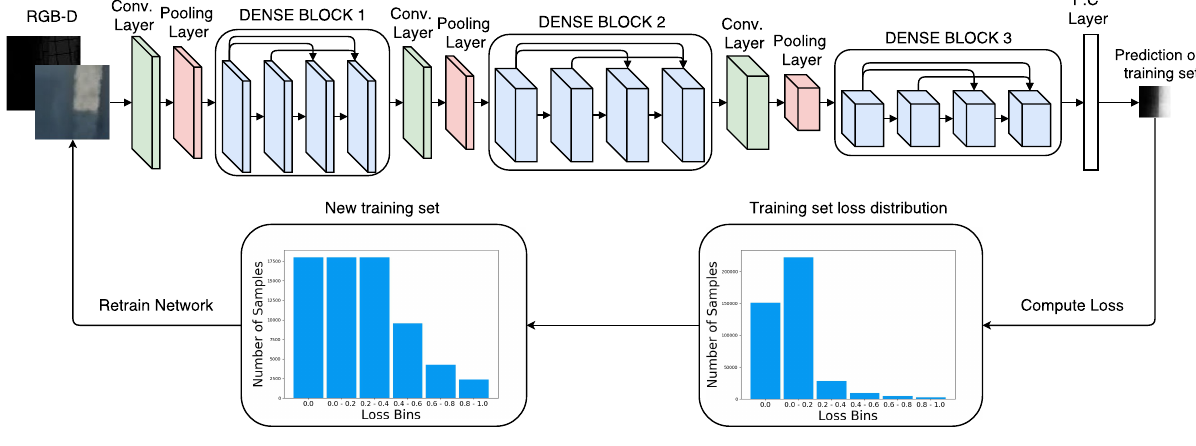
Figure 5. Bootstrapping framework with DenseNet. An RGB-D patch is the input for the DenseNet. The trained model is used for inference on the training set and the training samples are re-sampled based on loss distribution to retrain the network.